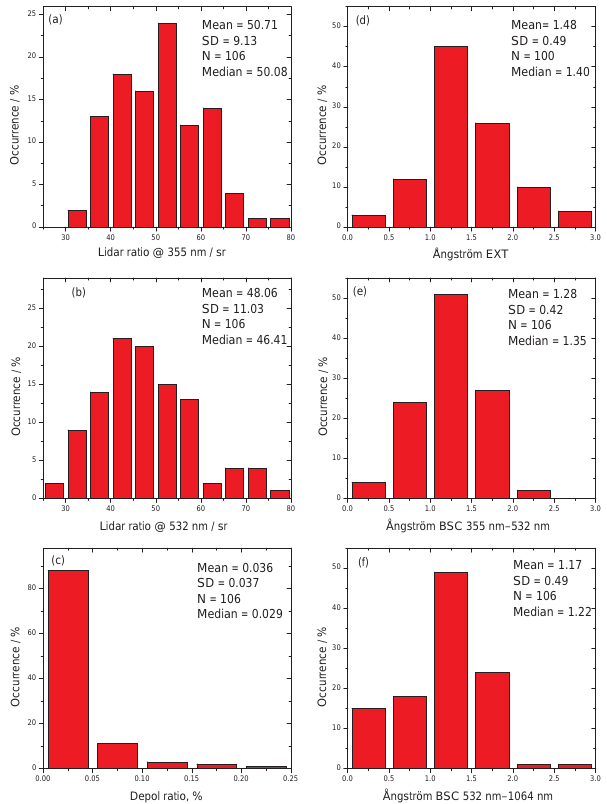
Figure 9. Statistical analysis of the optical properties of the ob- served lofted aerosol layers: (a) lidar ratio at 355nm, (b) li- dar ratio at 532nm, (c) linear particle depolarization ratio at 532nm, (d) extinction-related Ångström exponent at 355–532nm, (e) backscatter-related Ångström exponent at 355–532nm, (f) and backscatter-related Ångström exponent at 532–1064nm.